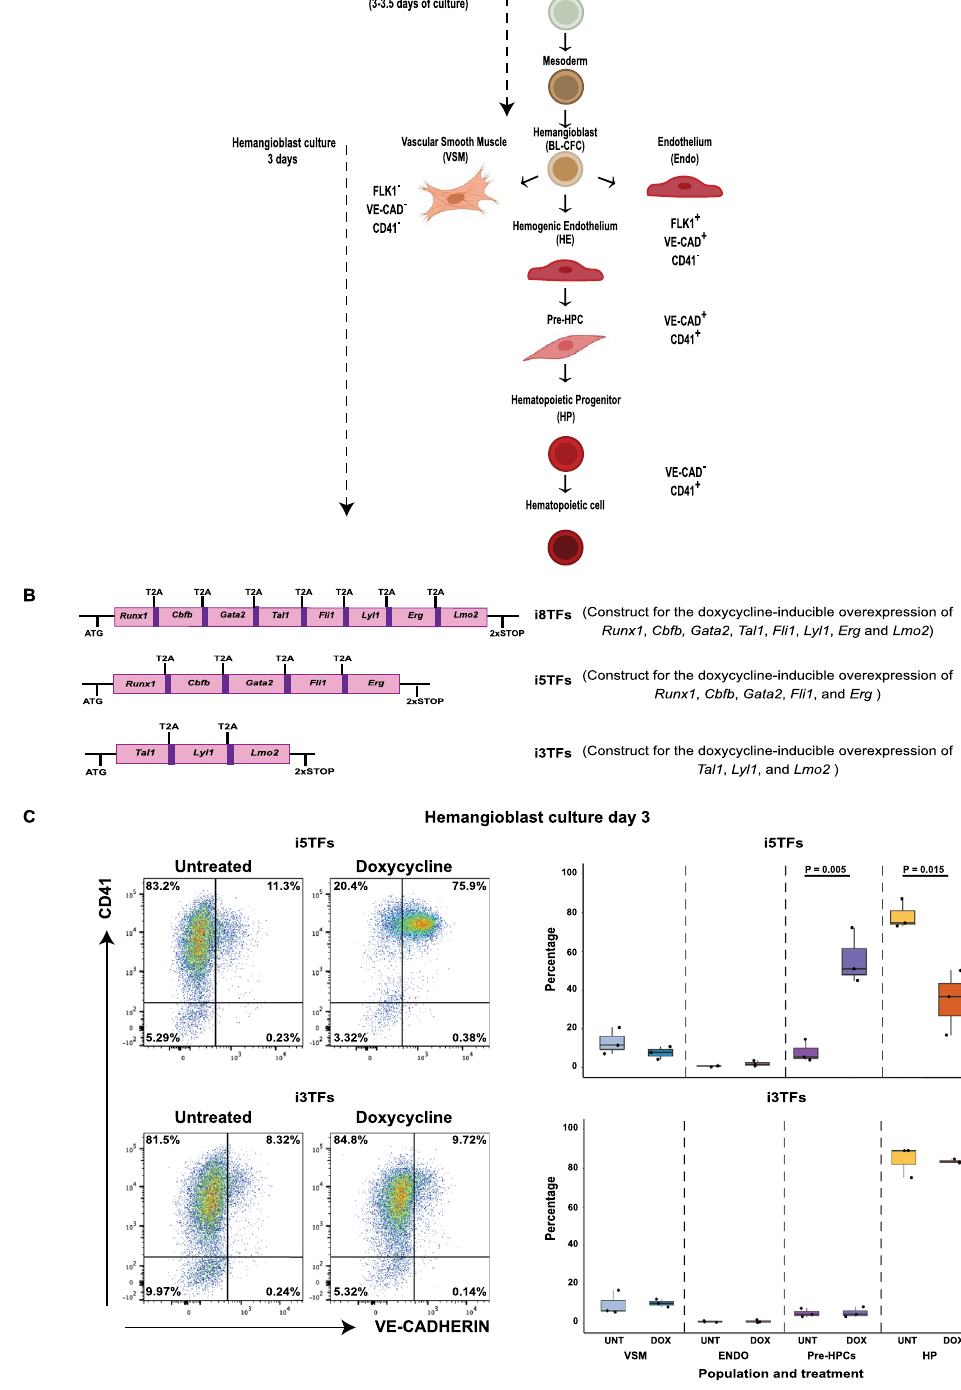
Figure 1. The simultaneous overexpression of Runx1 , Cbfb , Gata2 , Erg and Fli1 , but not that of Tal1 , Lmo2 and Lyl1 generates a hemangioblast culture enriched in cells resembling Pre-HPCs. ( A ) Scheme of the mESC differentiation system used in the study showing the cell-surface markers used to identify the different cell populations. ( B ) Schemes describing the transgenes used in the study. T2A = viral T2A peptide sequences inserted between the coding sequences of the genes to exploit the “ribosomal skipping” mechanism for the production of all proteins from one single transcript. ( C ) FACS analysis results showing the expression of VE-CAD and CD41 in day 3 hemangioblast cultures from i5TFs and i3TFs mESCs treated with doxycycline at day 1 of culture. Left: representative FACS plots. Right: Box plots summarizing the results of 3 experiments. Significance was determined by Analysis of Variance (ANOVA) test. Error bars correspond to standard